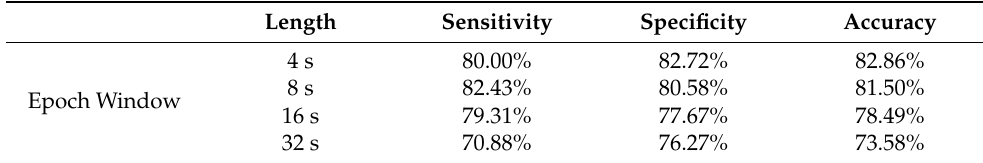
Table 4. Accuracy depending on the epoch length.